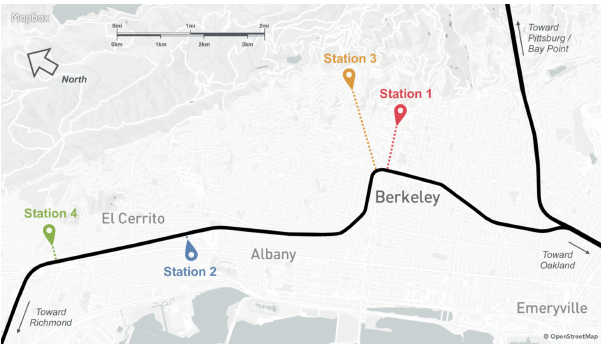
Figure 1. Map of Berkeley and location of the stations. The colored pins identify the locations of the magnetometers in our network. The black line shows the different paths of the BART trains. The shortest distance from each magnetometer station to the nearby BART line is represented by the dashed lines. Stations 1 to 4 are respectively located 1, 0.13, 2, and 0.36km from the BART